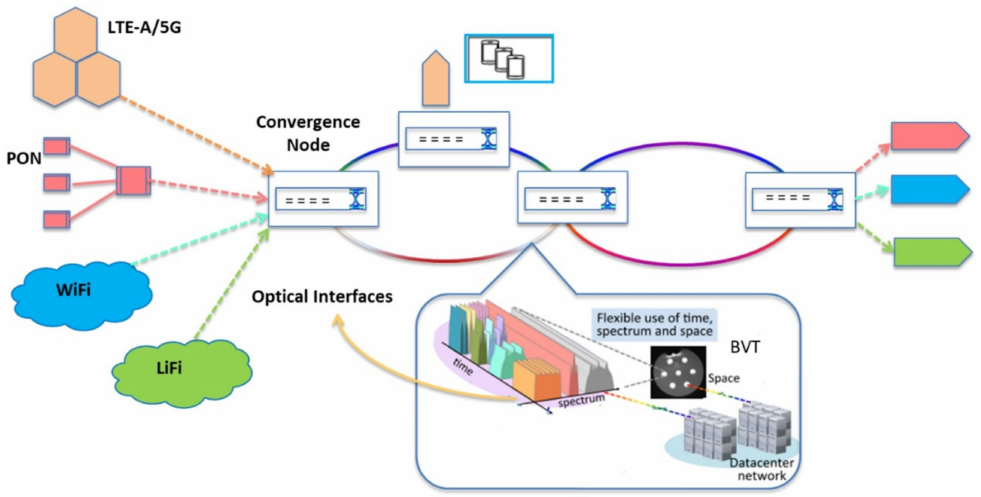
Figure 3. The generic convergence-node architecture. LTE-A: long term evolution advanced, PON: passive optical network, WiFi: wireless fidelity, LiFi: light fidelity, BVT: bandwidth variable